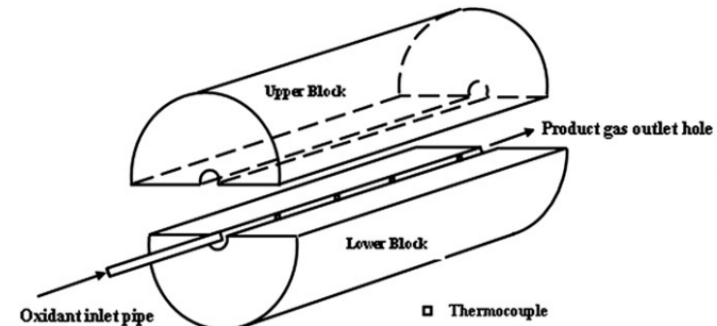
Figure 9. Experimental device for CRIP technology (from [32]).